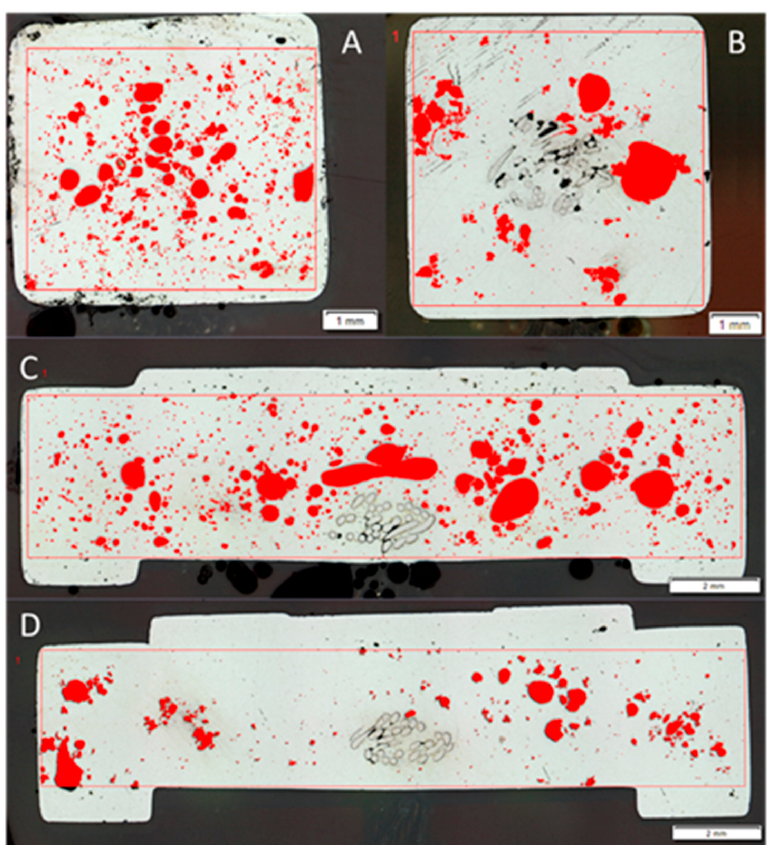
Figure 26. Terminal section with 200× optical zoom with porosity filter: before ( A , C ), and after the intervention ( B , D ). Table 4. Results obtained with the porosity analysis for the various